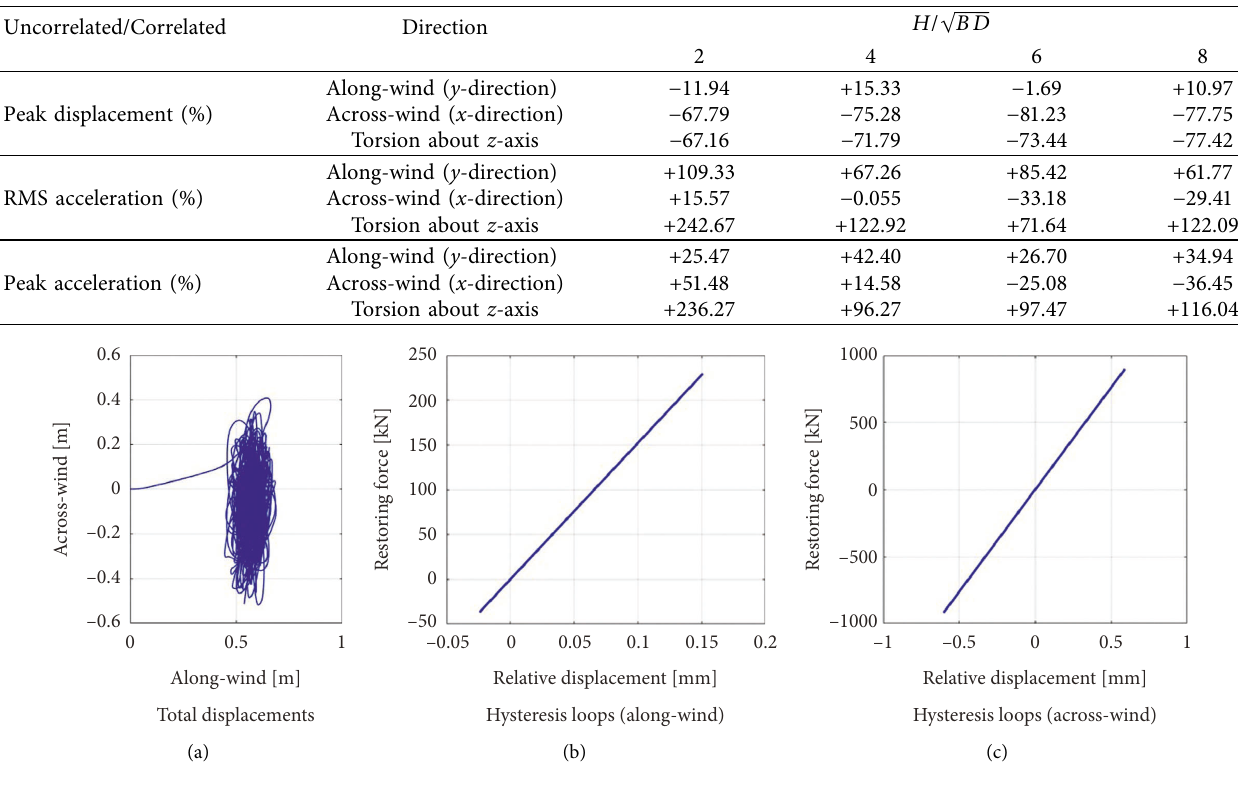
Figure 24: Nonlinear response in time domain of the 60 th floor H/sqrt(BD) � 8.